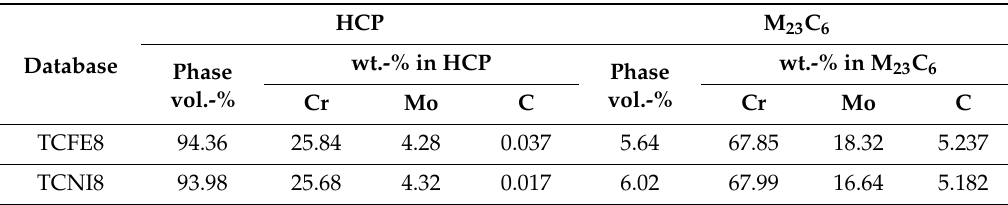
Table 3. Calculated phase compositions and phase fractions at 850 °C obtained using the TCNI8 and TCFE8 databases.